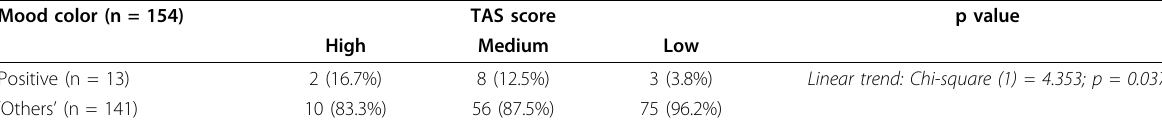
Table 4 Association between TAS score (hypnotic ability) and mood color choice Mood color (n = 154) TAS